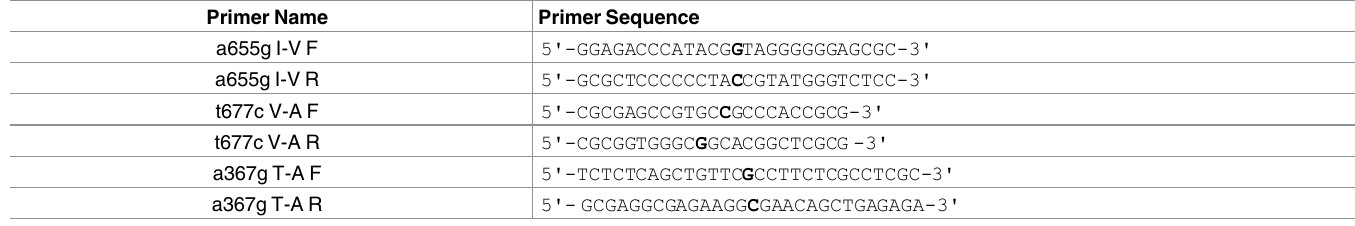
Table 1. Oligonucleotide Primers for site directed mutagenesis.